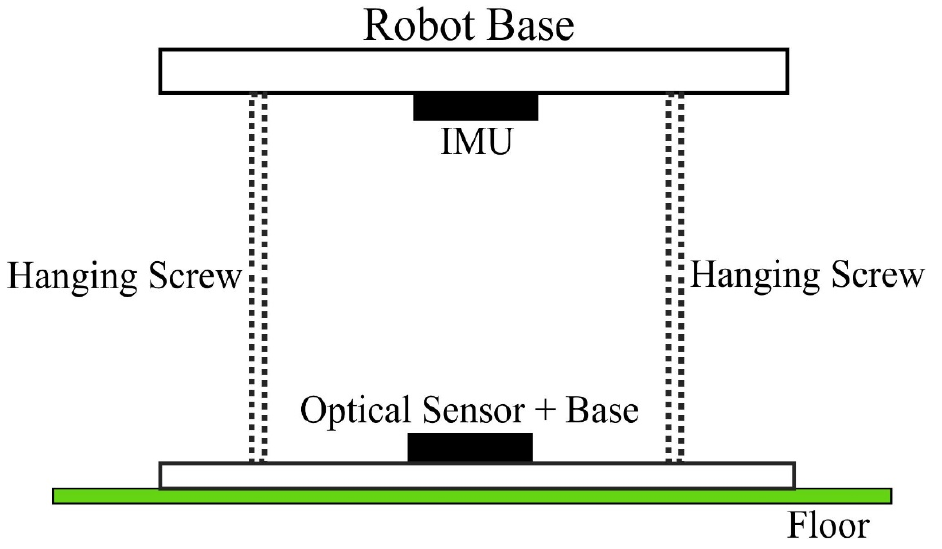
Figure 4. Composition of the optical mouse sensor and an inertial measurement unit coupled underneath the robot base.